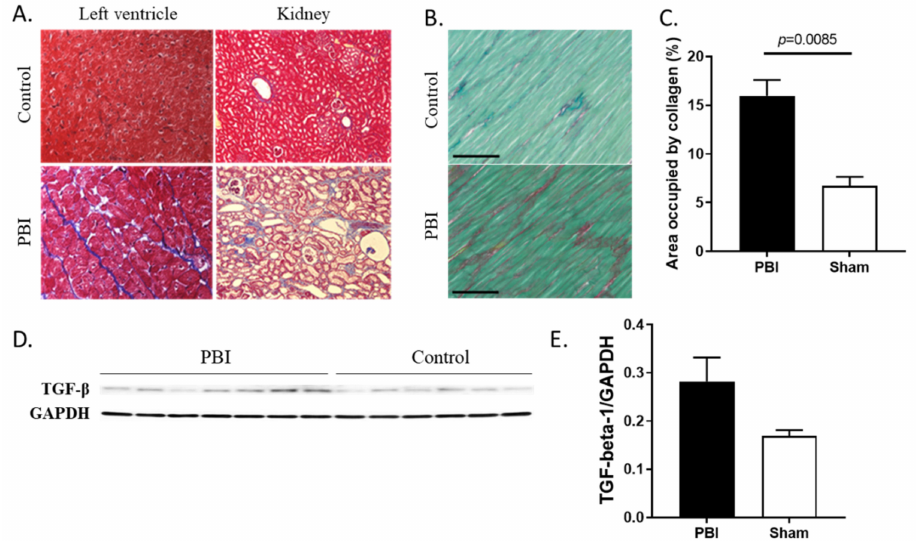
Figure 3. Analysis of fibrosis markers in heart and kidney samples of control and irradiated minipigs. ( A ) Histological analysis of collagen deposition in heart left ventricle (left) and kidney (right) sections using Masson’s Trichrome staining (blue staining). ( B ) Collagen deposition in the left ventricle was quantified using Sirius Red (red staining) supplemented with Fast Green to visualize cytoplasm; representative photomicrographs (20 × magnification; 100 µ m scale bar) are shown. ( C ) The percentage of left ventricular area occupied by collagen (field of view) was measured and averages are reported +/ − sem (control: n = 3; PBI: n = 7). ( D ) TGF-beta-1 expression was assessed by western blot analysis in heart lysates of irradiated and control animals; Glyceraldehyde 3-phosphate dehydrogenase (GAPDH) was used as loading control. ( E ) Densitometric quantification was performed and values were normalized to GAPDH and presented as averages +/ − sem.